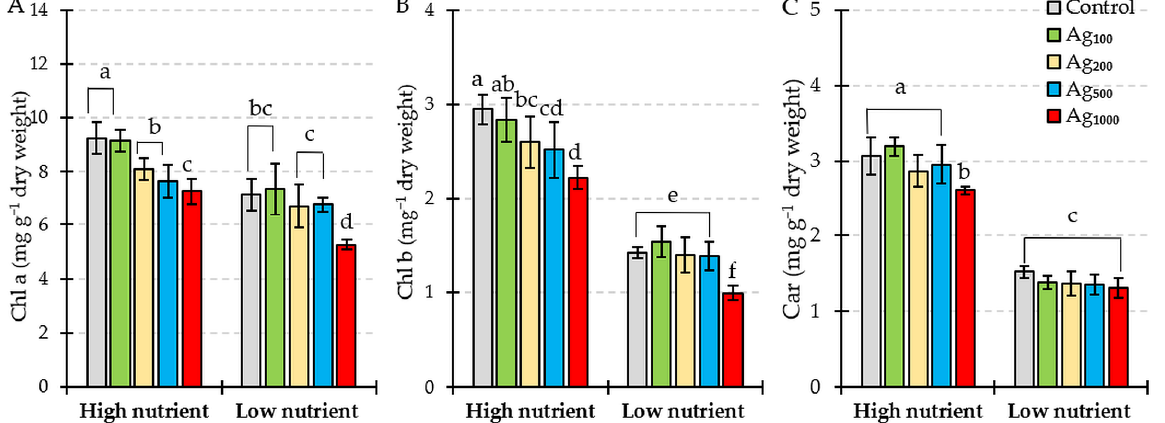
Figure 2. ( A ) Chlorophyll a (Chl a ), ( B ) chlorophyll b (Chl b ), and ( C ) carotenoid (Car) concentration in L. gibba exposed to a two-hour pulse of different colloidal silver concentrations (control = 0 µ g/L; Ag ₁₀₀ = 100 µg/L; Ag ₂₀₀ = 200 µg/L; Ag ₅₀₀ = 500 µg/L; Ag ₁₀₀₀ = 1000 µg/L) combined with two levels of total nitrogen and total phosphorus nutrition (high nutrients; low nutrients). Values shown are mean ± standard deviation of ten replicates ( n = 10). Different letters indicate significantly different values (HSD, p < 0.05).